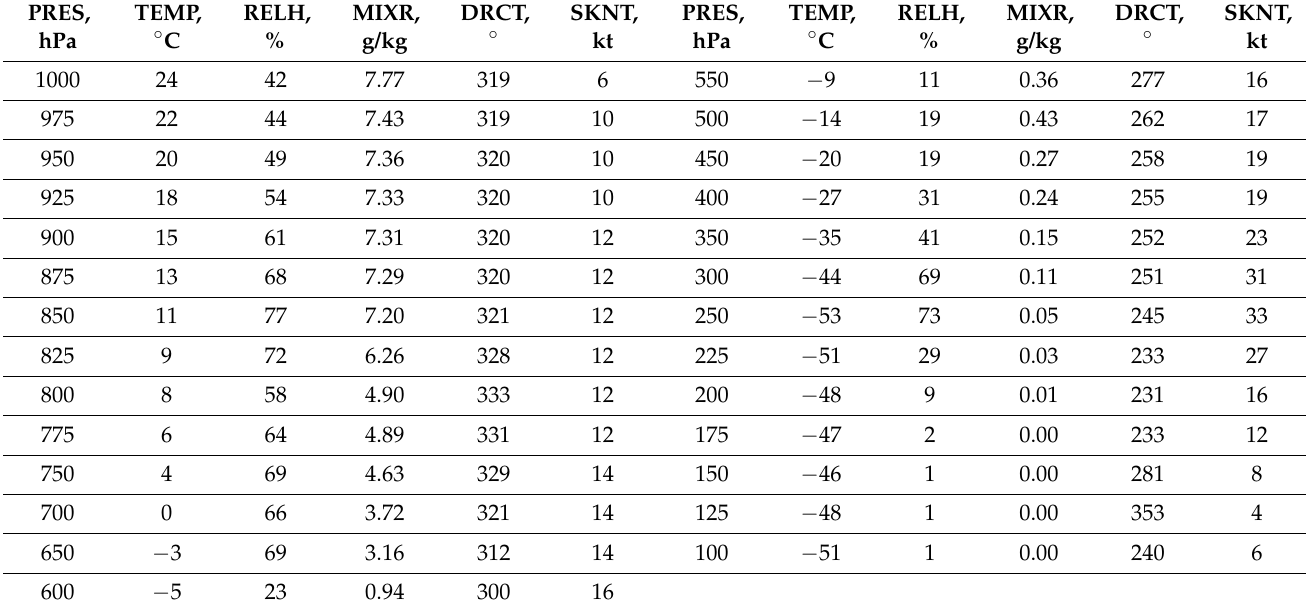
Table 3. Example of vertical profiles of meteorological characteristics [25] based on the ERA5